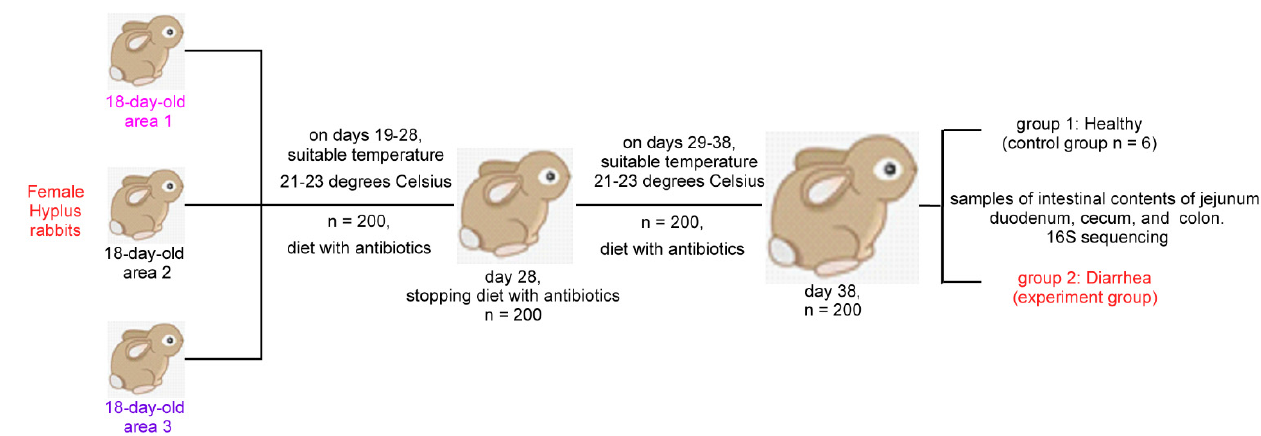
Figure 1. Overview of workflow for comprehensive analysis of intestinal microbiota of Hyplus rabbits of the same age group.